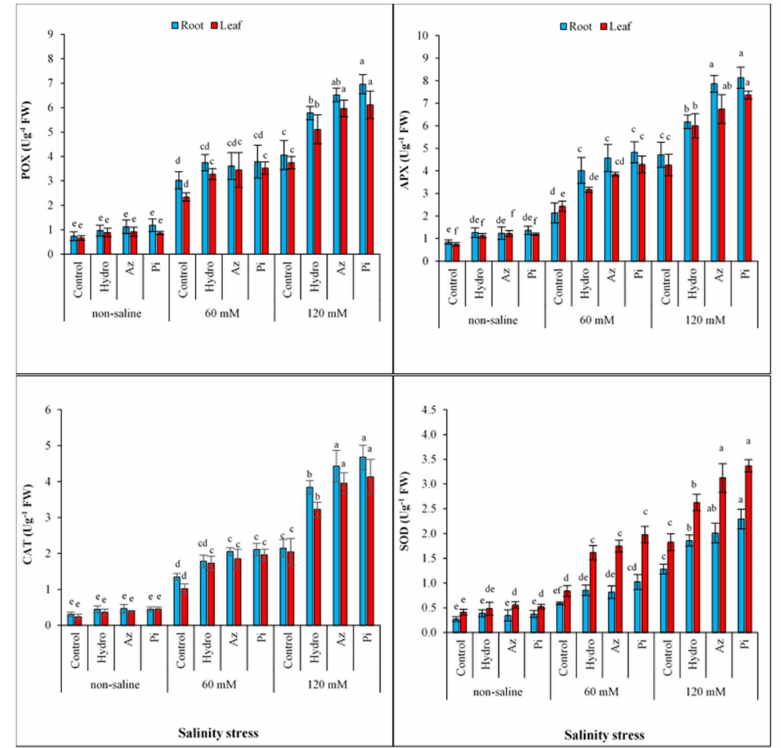
Figure 5. Effect of seed priming on peroxidase (POX), ascorbate peroxidase (APX), catalase (CAT) and superoxide dismutase (SOD) activities in root and leaves of milk thistle under different salinity levels. The same letter within each column indicates no significant difference among treatments ( p ≤ 0.05) using New Duncan’s test. Values mean of four replicates ± SD. Hydro: hydro-priming, Az: Azotobacter chroococcum and Pi: Piriformospora indica .